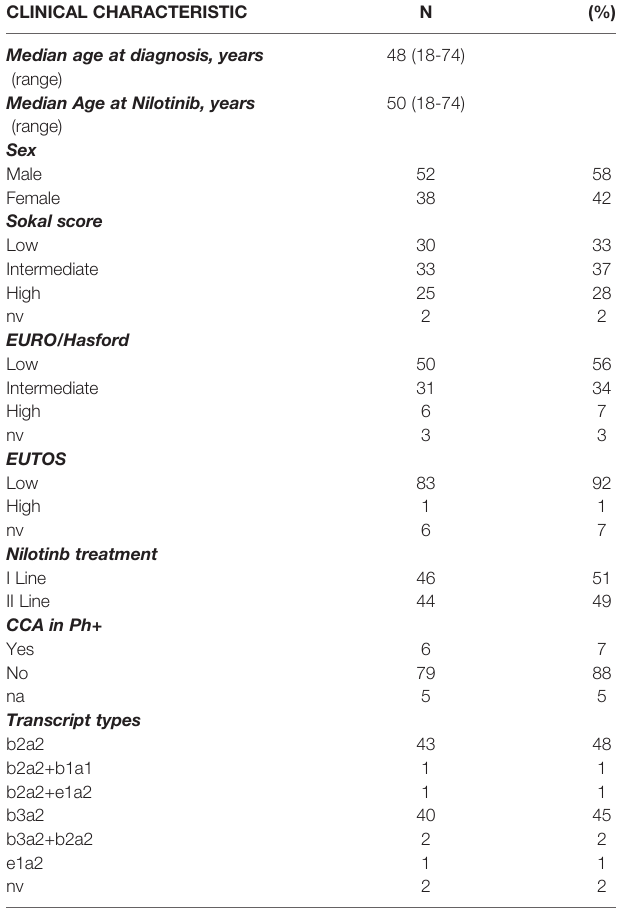
TABLE 2 | Patients characteristic.